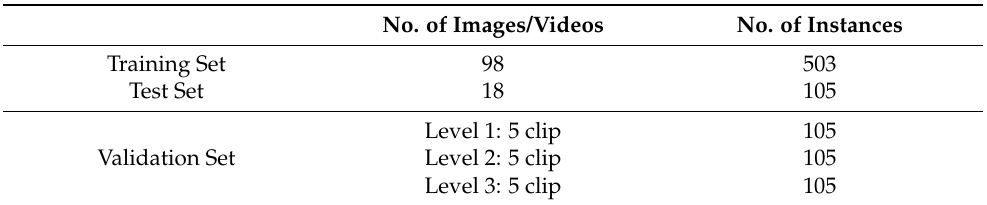
Table 1. Distribution of the OCIS